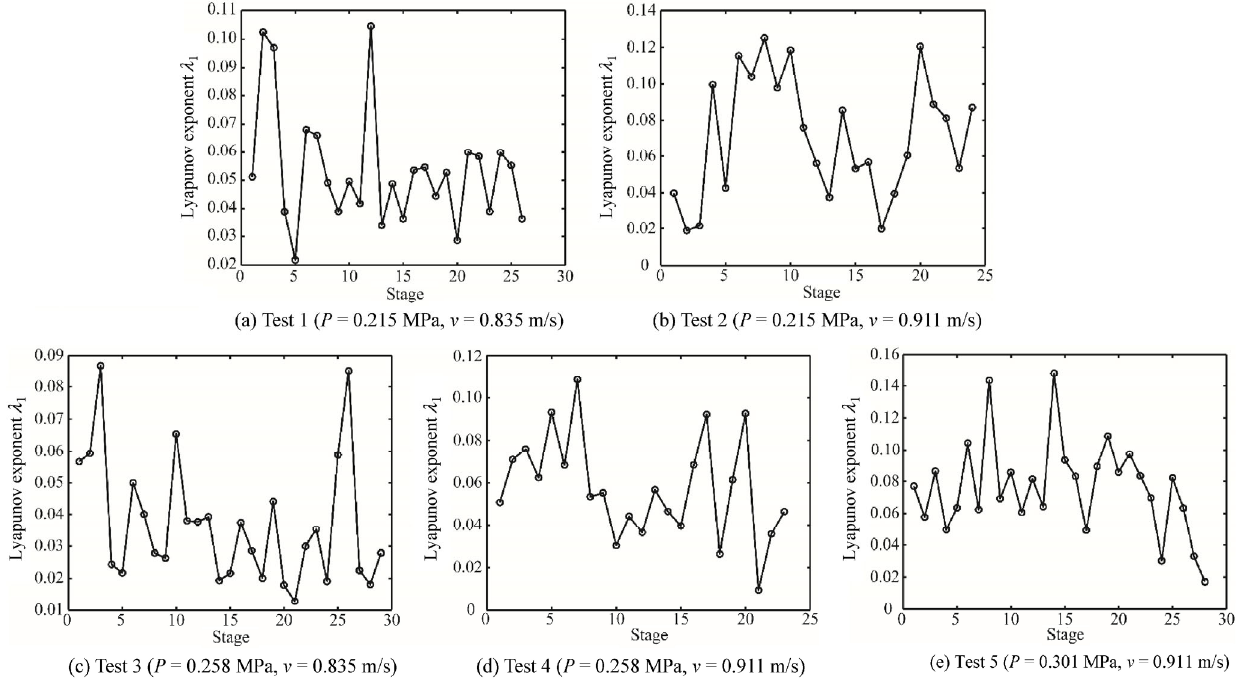
Fig. 10 Largest Lyapunov exponent of friction noise in the friction